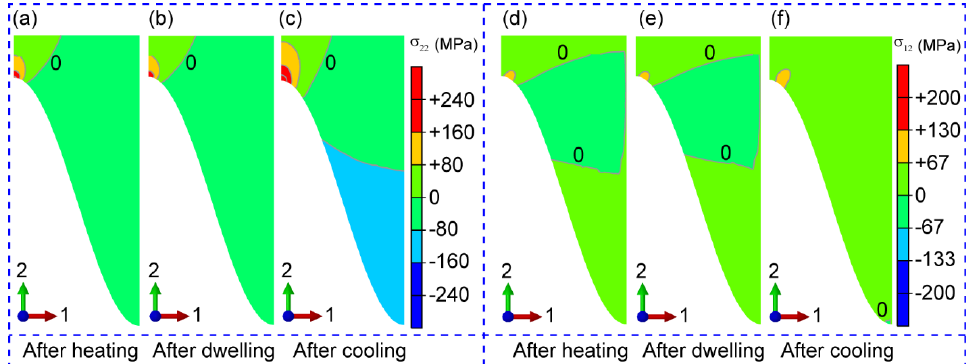
Fig. 23 Stress distributions in the ceramic layer during one thermal cycle: (a–c) normal stress and (d–f) shear stress. Reproduced with permission from Ref. [133], © ASM International 2019.